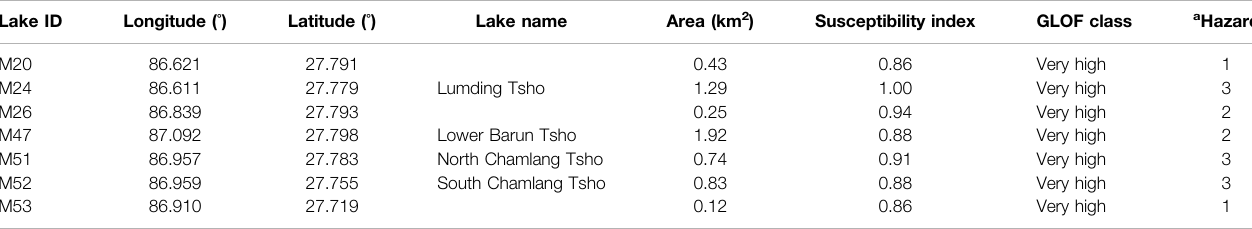
TABLE 4 | Glacial lakes with very high GLOF susceptibility across Mahalangur Himalaya. Lake